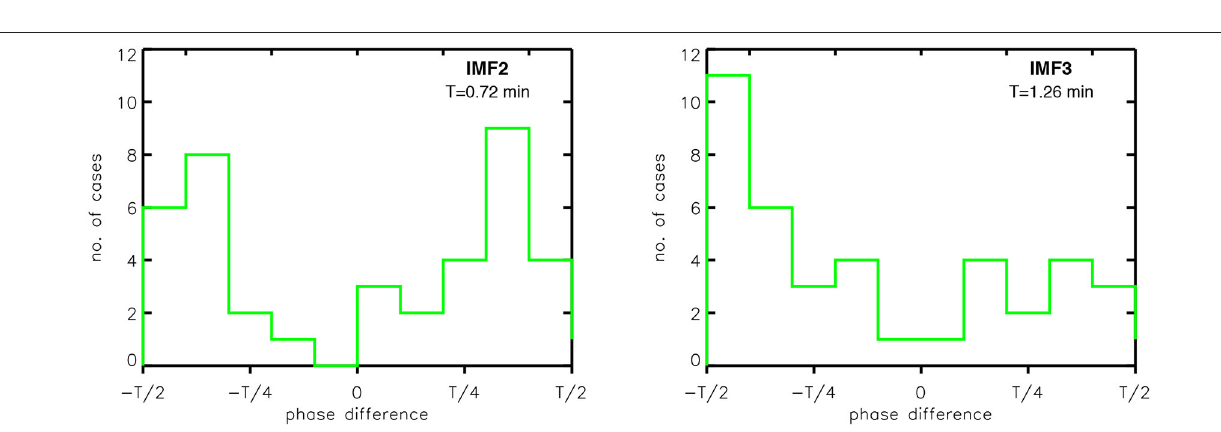
FIGURE 9 | Histograms showing the distribution of phase-difference between total intensity and Doppler velocity for IMF2 and IMF3 for the 40 selected